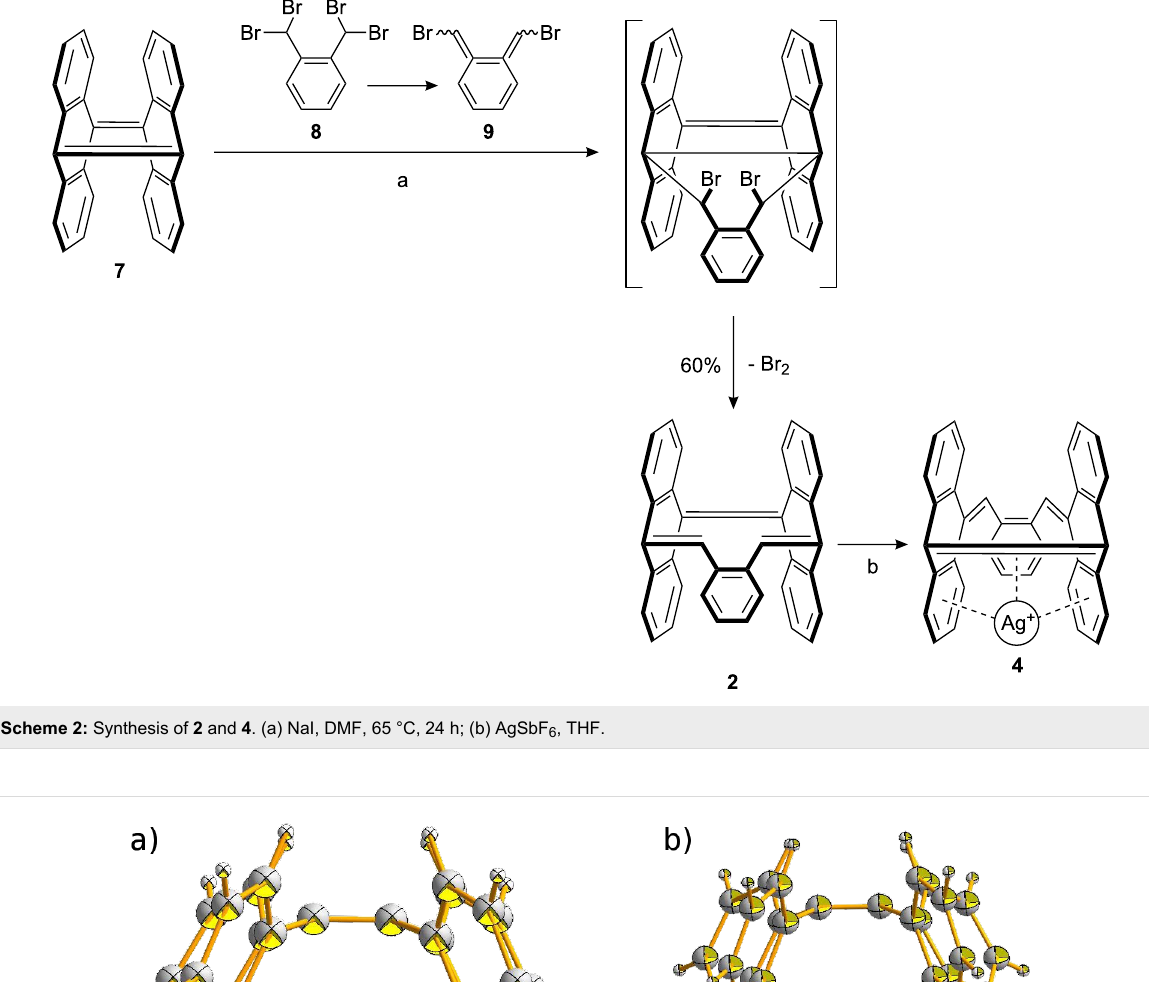
A number of aromatic hydrocarbons form 1:1-complexes with silver(I). In all - Z -tribenzo[12]annulene [23], for instance, the Ag + ion is coordinated by three double bonds in a